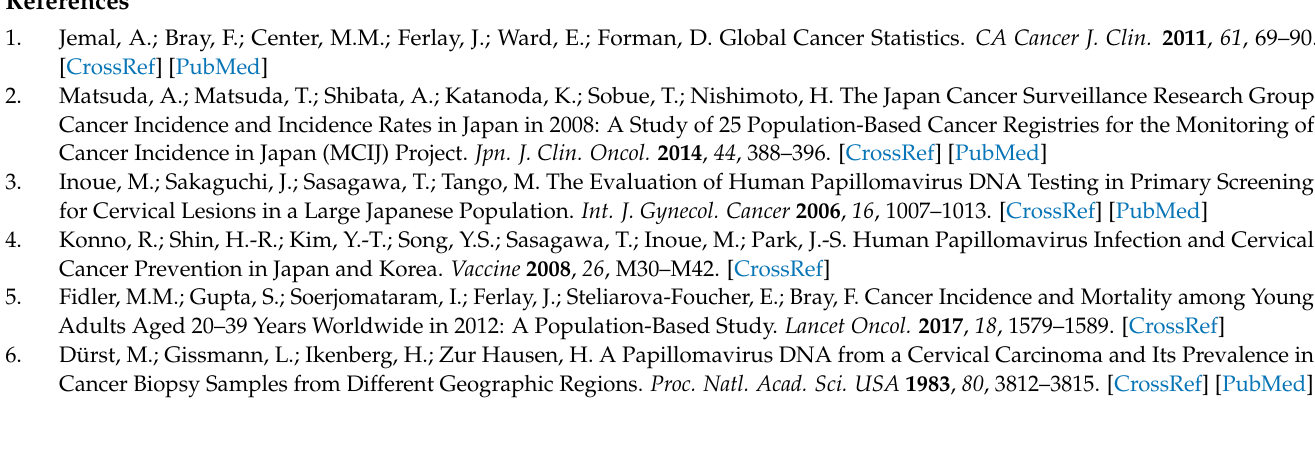
study; Table S2: The cervical cancer screening participation status and reasons for non-participation; Table S3: 27 variables of the health belief model in this